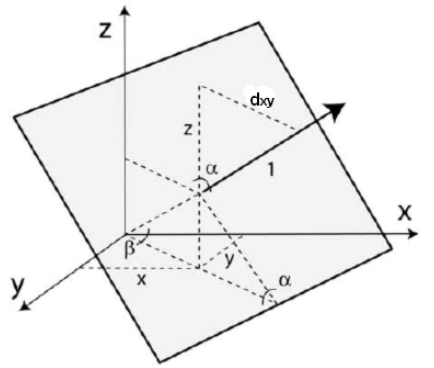
Figure 2. Decomposition of normal unit vectors of a DTM grid cell into x , y and z components using slope α and aspect β . Graphic from Sappington et al.